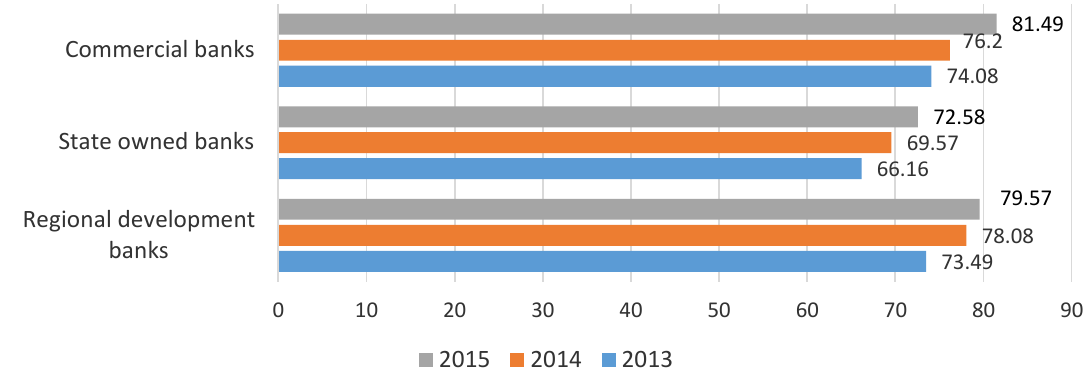
Figure 2. The ratio of operating expenses to operating income of commercial